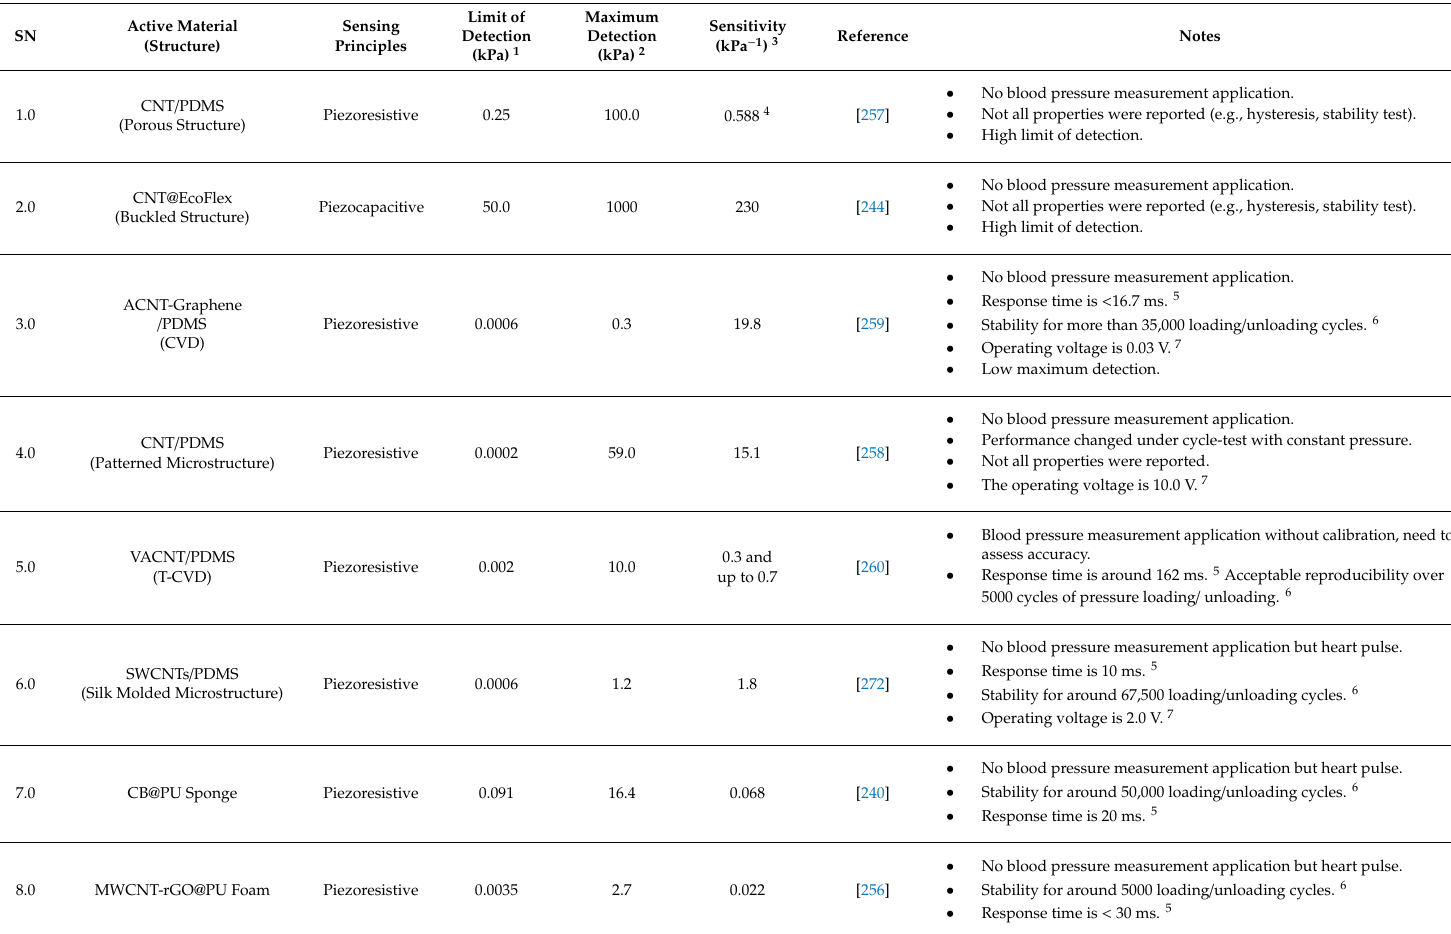
Table 4. Summary of active materials, sensing principles used in wearable sensors along with their sensing